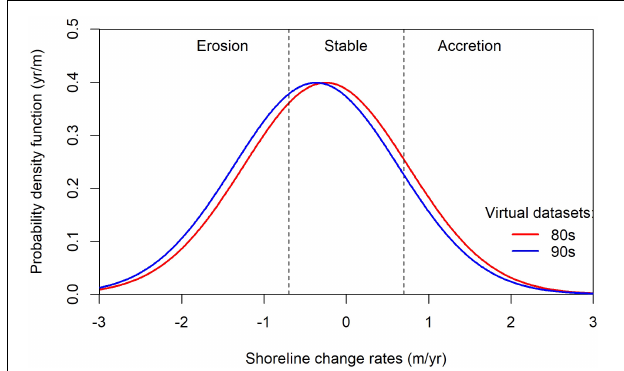
FIGURE 4 | Shoreline change datasets used in section “Application on a Virtual Dataset” to illustrate the method used in this study. The blue probability density function refers to a virtual dataset based on small beaches in the European coastal database. The red probability function superimposes the effects of sea-level rise to the same dataset, as in eqn.